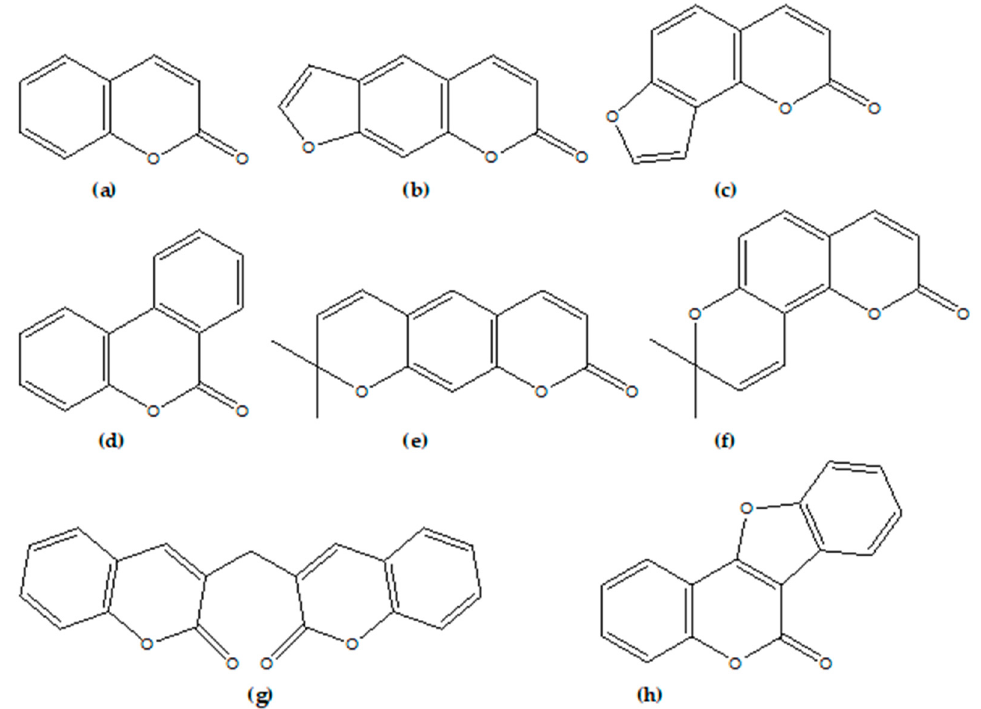
Figure 1. Six basic groups of natural coumarins: ( a ) simple coumarins; ( b ) furanocoumarins (linear type); ( c ) furanocoumarins (angular type); ( d ) benzocoumarins; ( e ) pyranocoumarins (linear type); ( f ) pyranocoumarins (angular type); ( g ) biscoumarins; ( h ) coumestans.